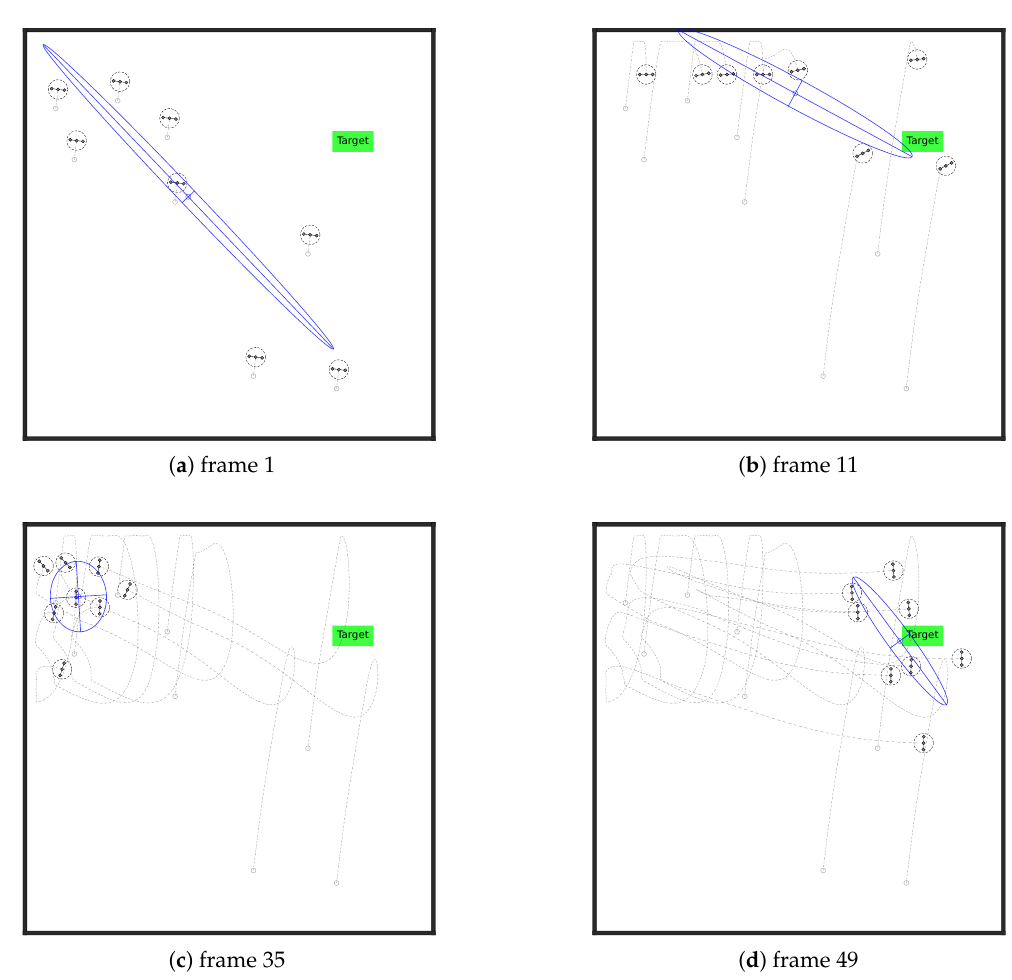
Figure 3. Different stages of N = 8 underactuated robots using our nonlinear controller (Equation (45)). ( a ) Initial condition. ( b ) Hysteresis-based control following Algorithm 2. ( c ) Mini- mizing mean and variance of robot positions utilizing the arena boundary. ( d ) Regulating mean state and stabilizing the Euler angle θ